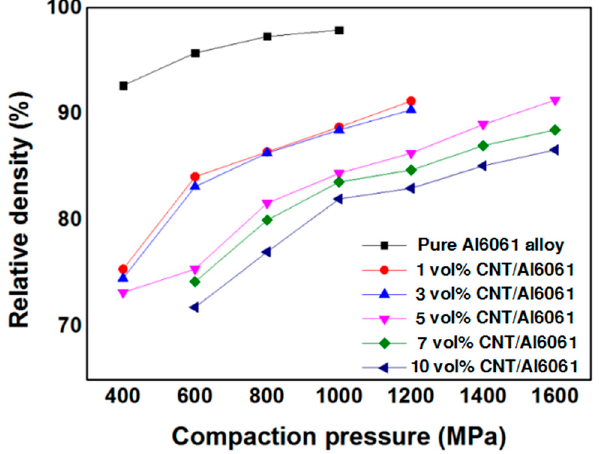
Figure 4. Change phenomenon in the relative density of each material depending on compaction pressure.